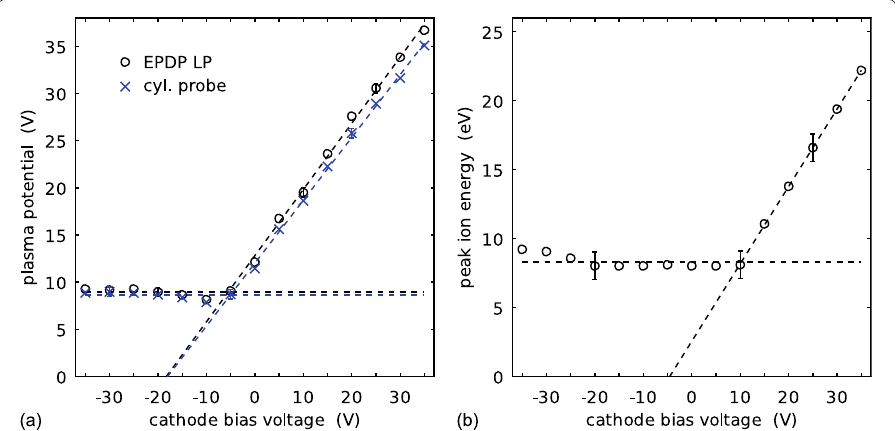
Fig. 9 Variation of the (a) plasma potentials and (b) ion energies for different potentials of the hot filament. The plasma sensor and the cylindrical Langmuir probe were at distances of 18cm from the beam axis on opposite sides of the chamber. The 100 μ m tungsten hot filament was heated by a current of 1.7A, the potential drop along the filament was